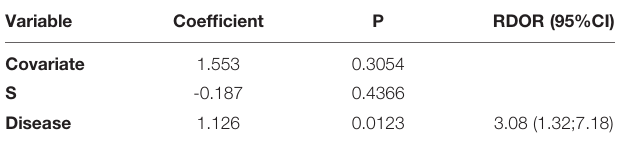
TABLE 2 | The result of